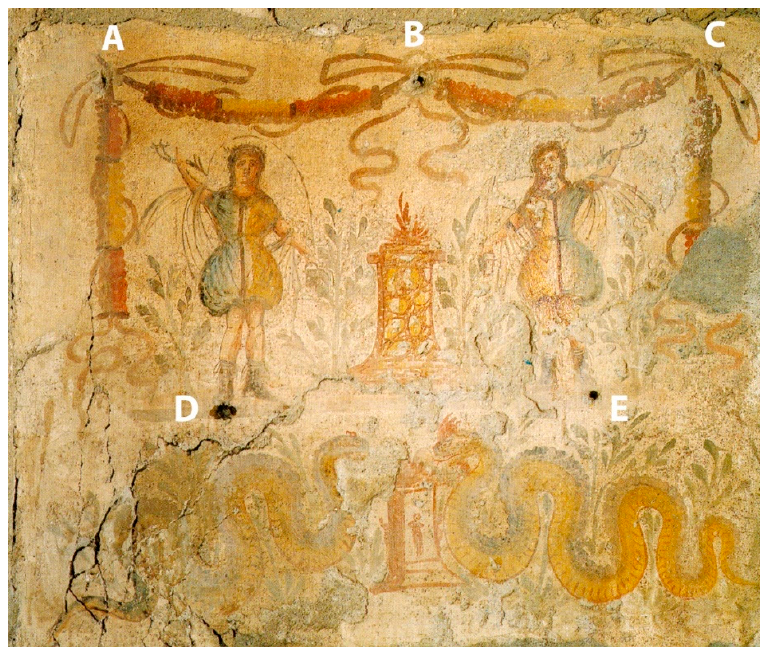
Figure 8. Caupona di Soterius (1.12.3), Pompeii. Two lares flank a circular altar, with two snakes below approaching another altar. Three holes for hanging a garland on the top register are indicated by letters ( A – C ); two holes for hanging a separate garland below or a shelf are indicated by letters ( D , E ). (Modified by author, after Fröhlich 1991, Taf. 4.2).